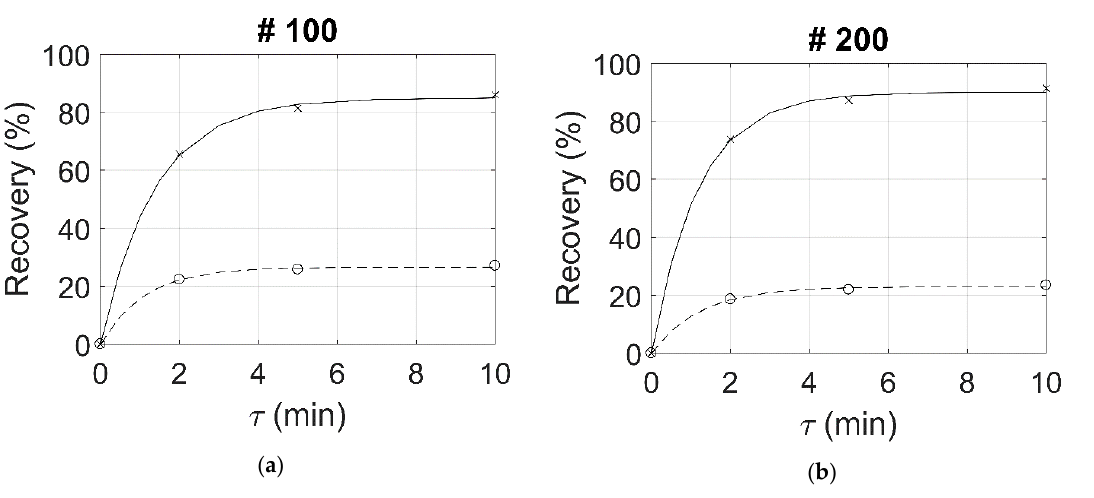
Figure 1. ( a ) (#100) ( b ) (#200). Native flotation kinetics of talc ore using methyl isobutyl carbinol (MIBC) frother. The (x) and (o) mark the recovery of talc and gangue minerals, respectively. Table 4. Results of the analysis of variance (ANOVA) test ( p -values). Froth Yield Froth